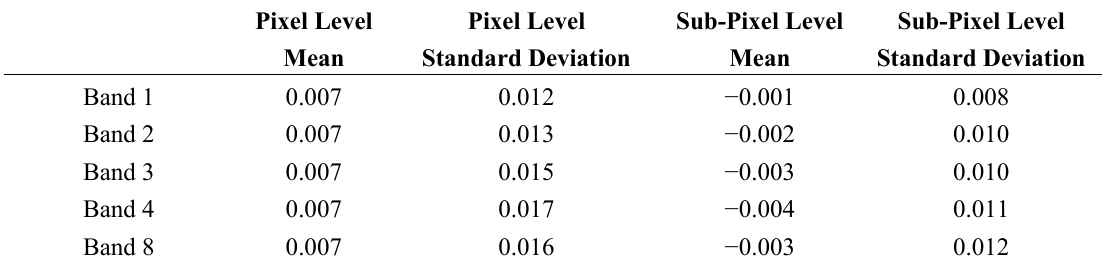
Table 1. Difference mean and standard between the reference reflectance and pixel ( left ) or sub-pixel ( right ) topographically corrected reflectance for Landat-7 band 1, 2, 3, 4 and